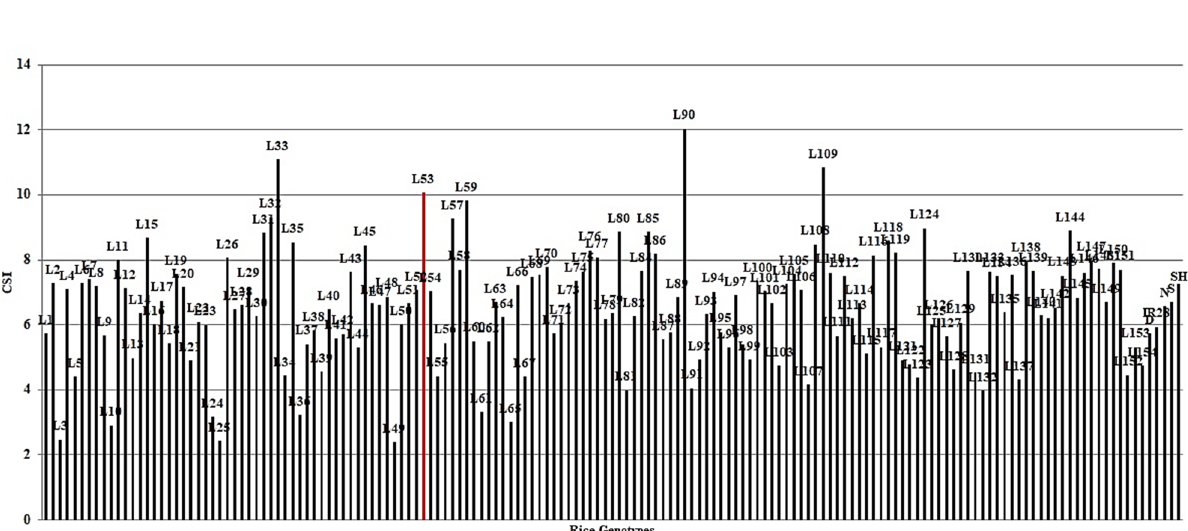
Figure 7. The CSI value for 152 rice RILs, parental (IR28 and SH: Shahpasand) and check varieties (N; Neda, S; Sadri, D; Dorfak) based on overall mean of lines during 3 years